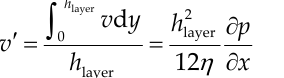
Fig. 5 Spread of the separated part due to capillary pressure.